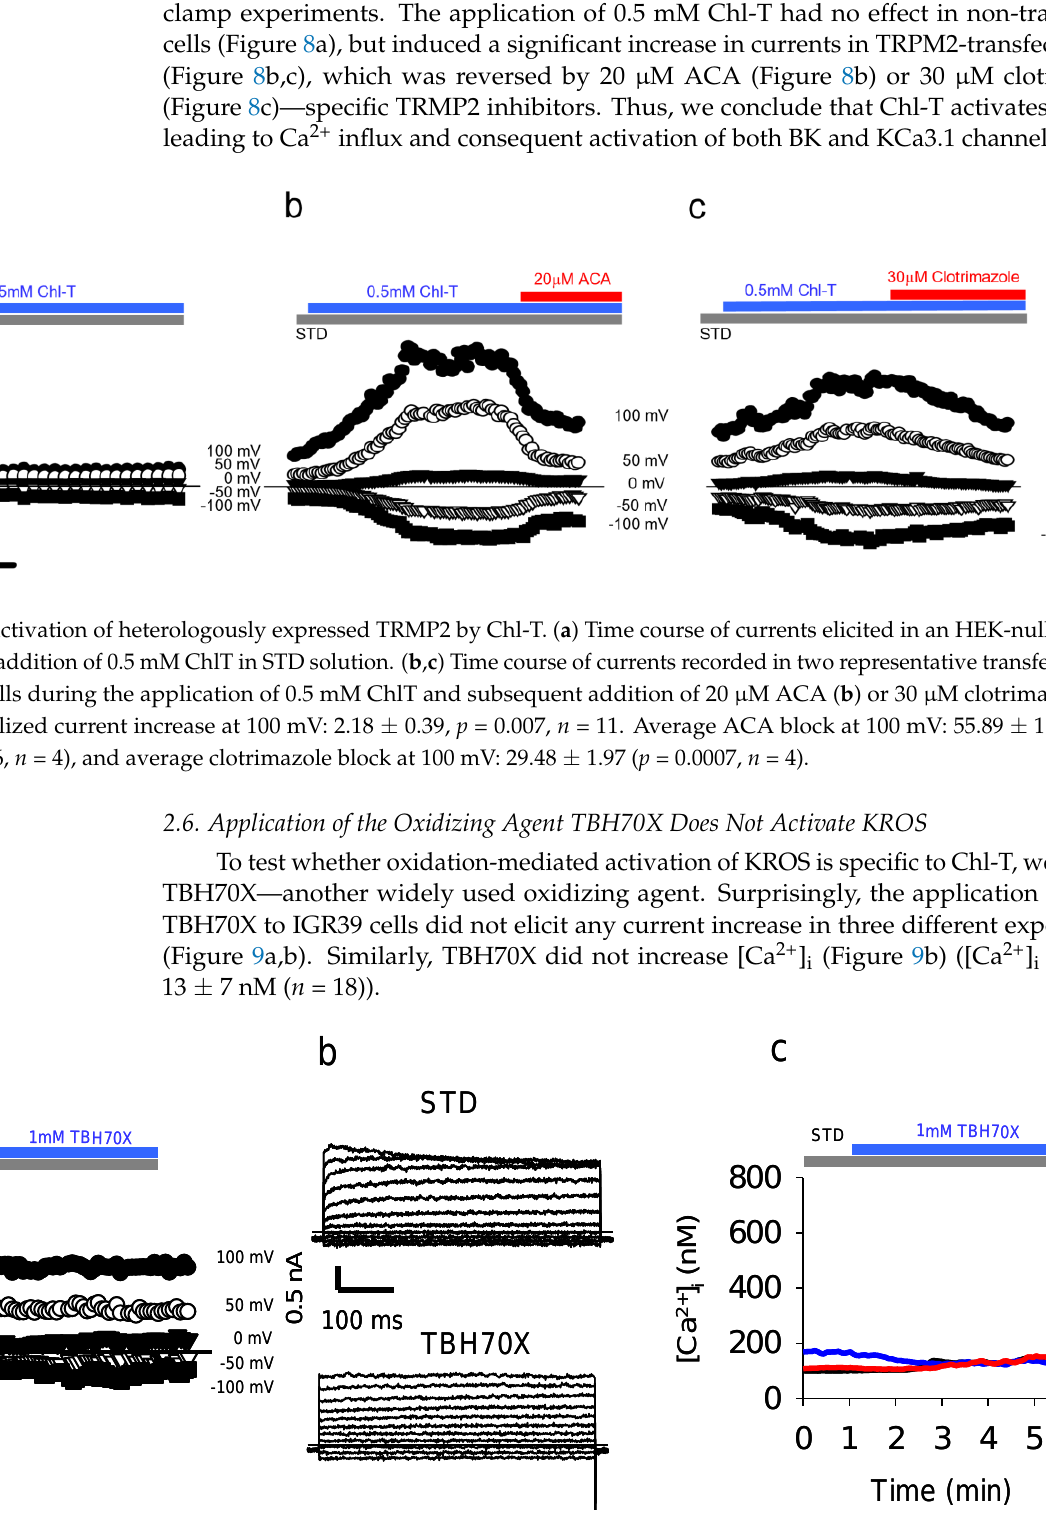
Figure 9. Application of TBH70X does not activate currents in IGR39 cells. ( a ) Time course of currents elicited in an IGR39 cell during the application of 1 mM TBH70X in STD solution, at different potentials from − 100 mV to +100 mV, as indicated. ( b ) Representative current recorded in the same IGR39 cell elicited before and after the addition of 1 mM TBH70X. ( c ) Representative traces of [Ca 2+ ]i after the application of 1mM TBH70X in the standard bath solution containing 2 mM Ca 2+ .